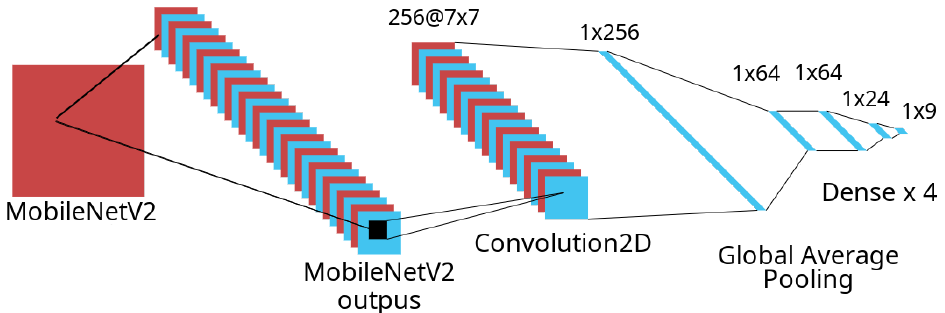
Figure 5. Architecture of the complete model with pre-trained MobileNet-v2 model and added custom layers on top of it.